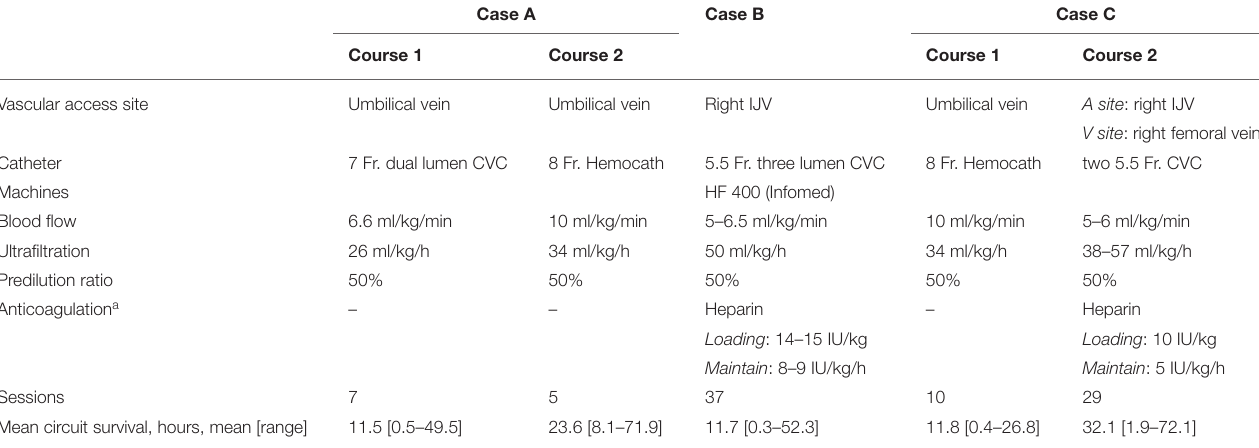
TABLE 2 | Continuous kidney replacement therapy setting of our three